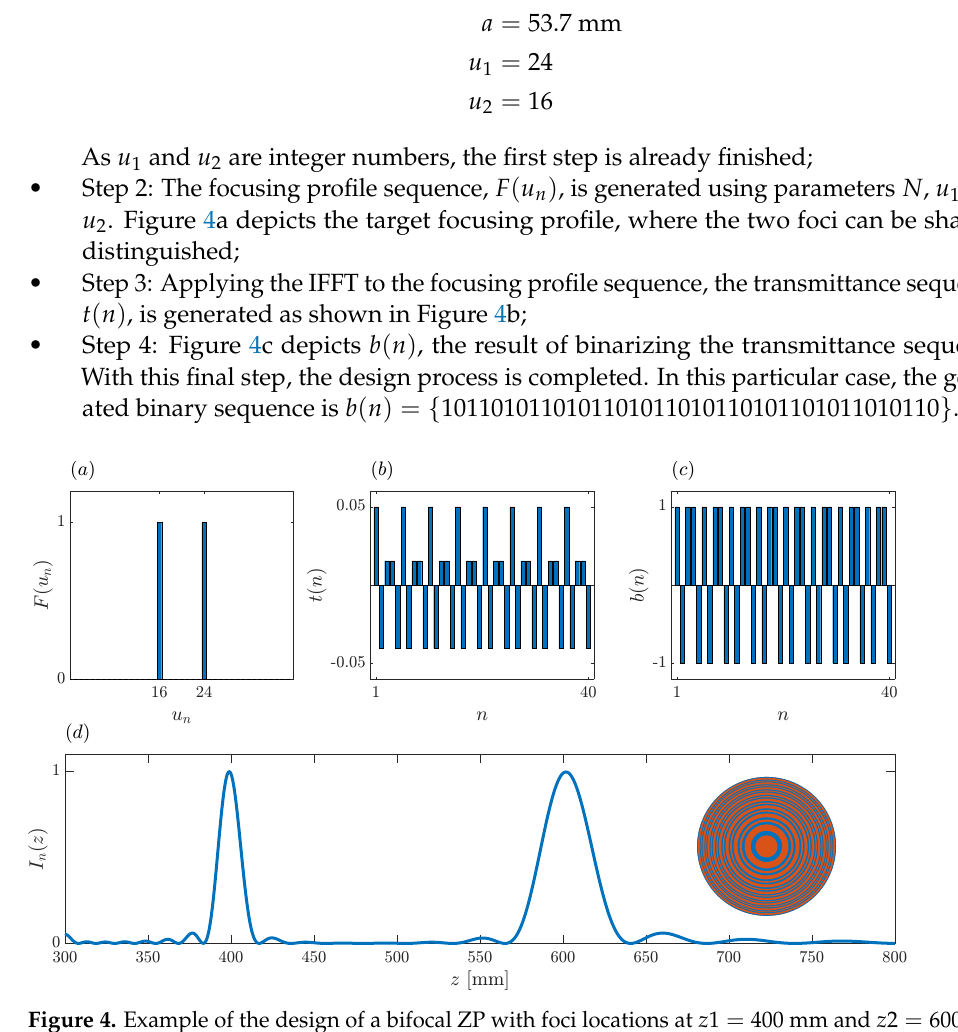
Figure 4. Example of the design of a bifocal ZP with foci locations at z 1 = 400 mm and z 2 = 600 mm. ( a ) Focusing profile sequence. ( b ) Transmittance sequence. ( c ) ZP binary sequence. ( d ) ZP bifocal normalized focusing profile. Inset: Bifocal ZP layout with transparent areas (red) and phase-reversal areas